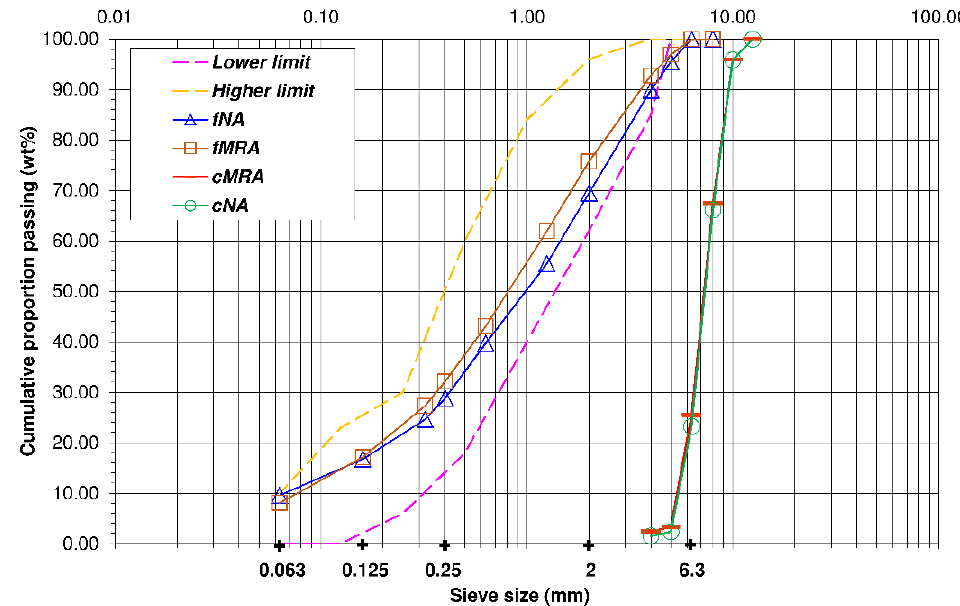
Figure 2. Granulometric distribution of aggregates (NA and MRA).